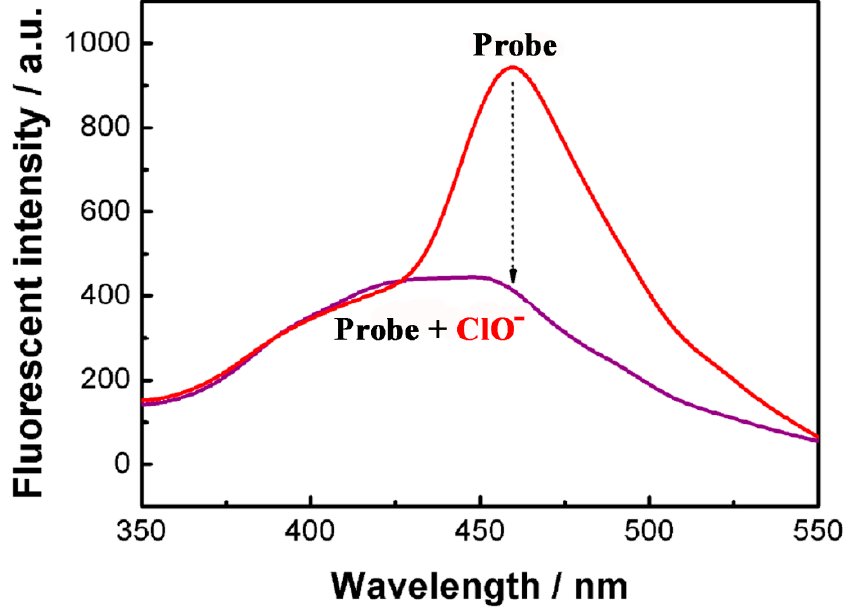
Figure 4. Fluorescence spectrum of the probe (red line); fluorescence spectrum of the probe in the presence of ClO − (purple line). c (probe, μ L): 20; c (ClO − , μ M): 50; 40 mM phosphate buffer solution: pH 8.0; temperature (°C): 25 (room temperature); reaction time (minutes): 5; λ ex : 285 nm; λ em : 420 nm, 460 nm.